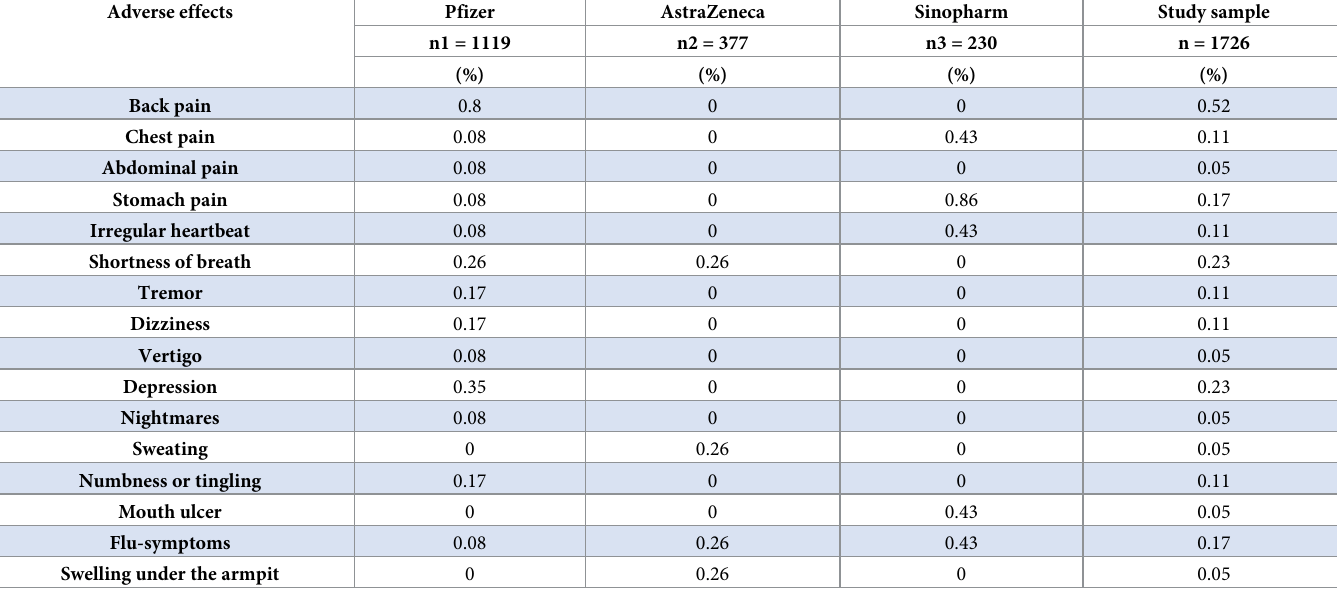
Table 3. Other unlisted adverse effects associated with the second dose of COVID-19 vaccines. Adverse